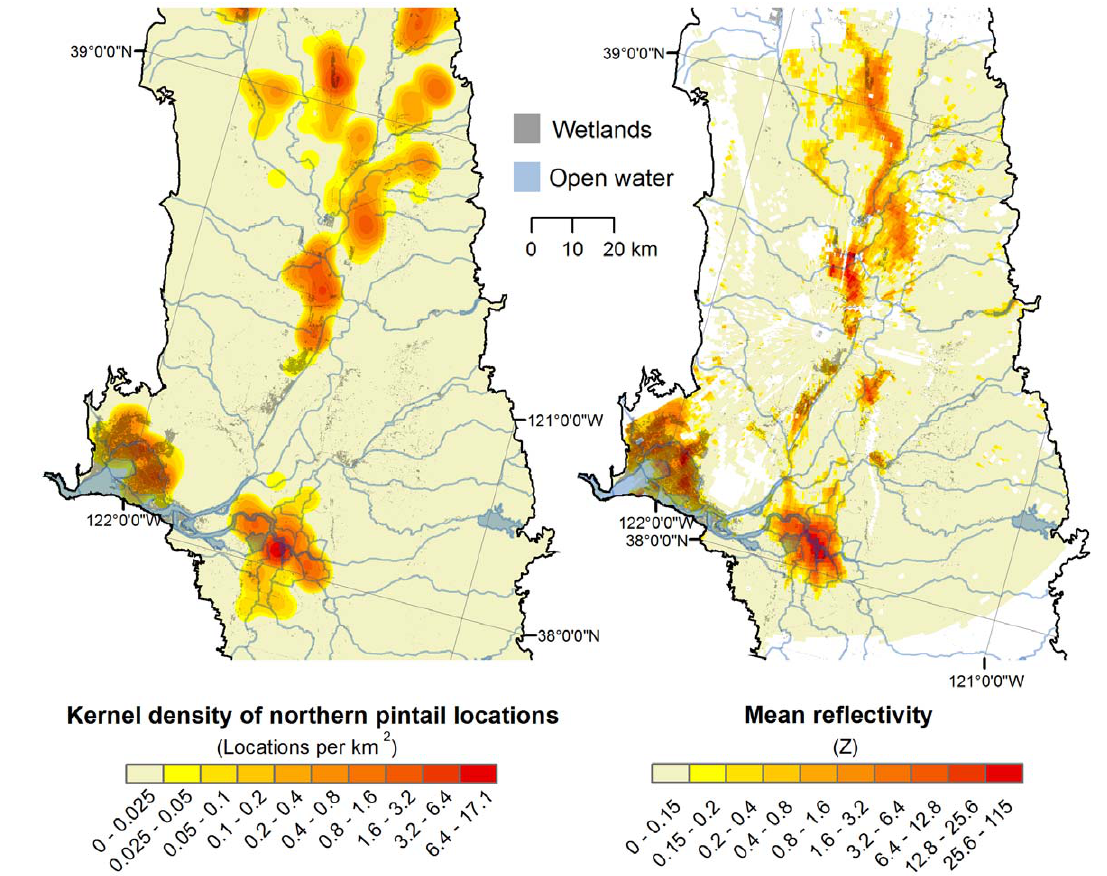
Figure 5. Maps of wintering waterfowl distributions. Maps of the 5-km-bandwidth kernel density of radio-marked northern pintail locations ( n =3 102) and the mean radar reflectivity (i.e., index of bird density) around the KDAX radar ( n =18 days) during winter 1998–1999. White areas denote regions where radar data were masked from analysis.